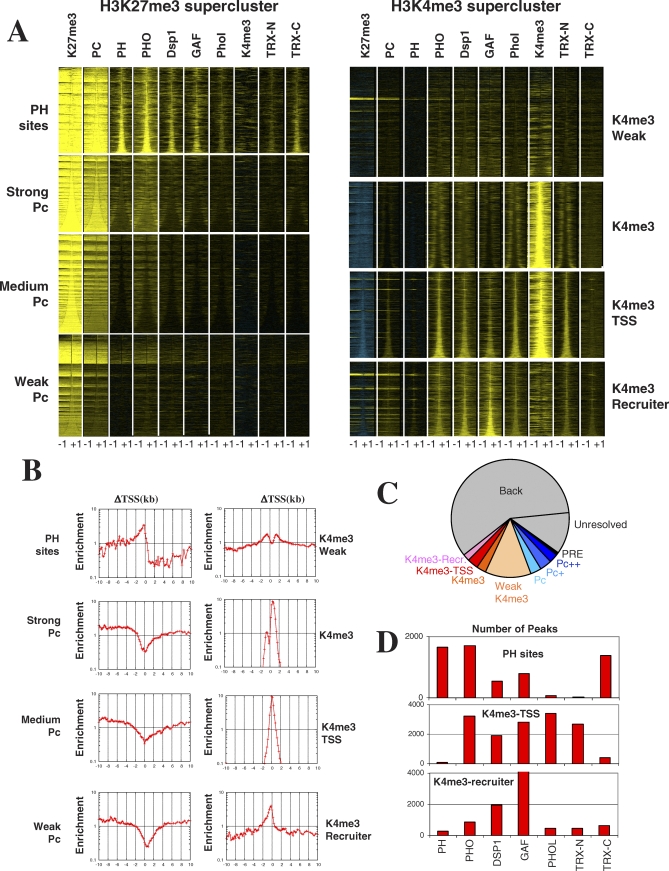
Genome-Wide Architecture of Polycomb and Trithorax Marks and Recruiters(A) Spatial clusters. We dissected our multifactor genome-wide dataset into groups of loci with common factor and histone mark occupancy (spatial clusters). Clusters are probabilistically tied together to reflect a typical genomic organization (Figure S18). Our algorithm detected two superclusters, one representing H3K27me3-marked domains (left) and the other representing H3K4me3-marked domains (right), and further decomposed each supercluster into distinct genomic behaviors. Here, we depict each cluster as a block, where rows represent the 2 kb (−1 kb to +1 kb) around cluster centers, color-coded to reflect the binding intensity of nine marks and factors (yellow indicates strong binding, blue negative enrichment).(B) We also plotted the enrichment of clusters' locations relative to the TSS (x-axis, zero reflect the TSS itself), normalized by the genome-wide frequency of distances from the TSS.(C) Frequency of clusters in the genome. The relative abundance of the eight clusters is shown. About two-thirds of the genome is not associated with either of our two superclusters (i.e., lboth H3K4me3 and H3K27me3 are lacking).(D) Transcription factor (TF) peaks in three clusters. We show the number of peaks (over 1.5 chip enrichment) for the PH sites, K4me3-recruiter, and K4me3-TSS clusters. The vast majority of TF peaks is observed in these three clusters, with some exceptions for GAF and TRX (unpublished data).